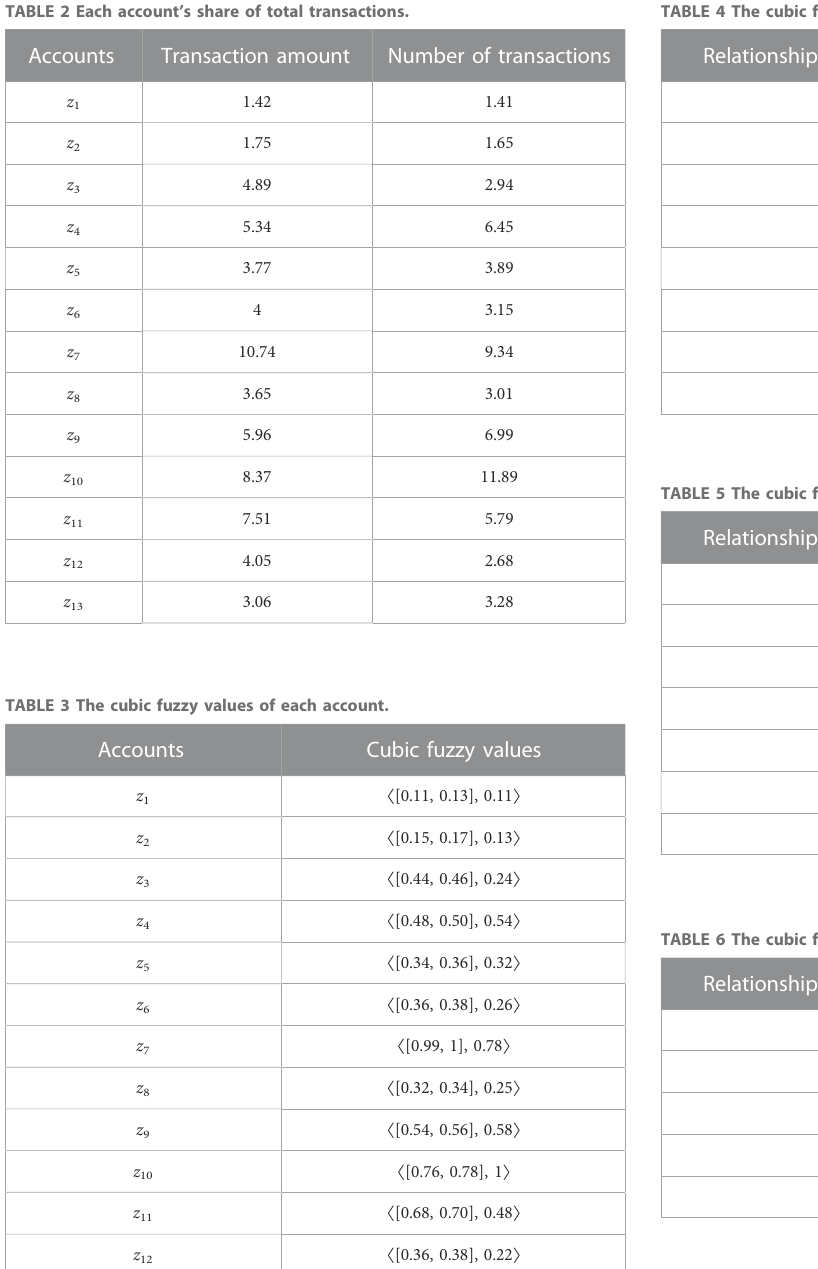
TABLE 2 Each account ’ s share of total transactions.